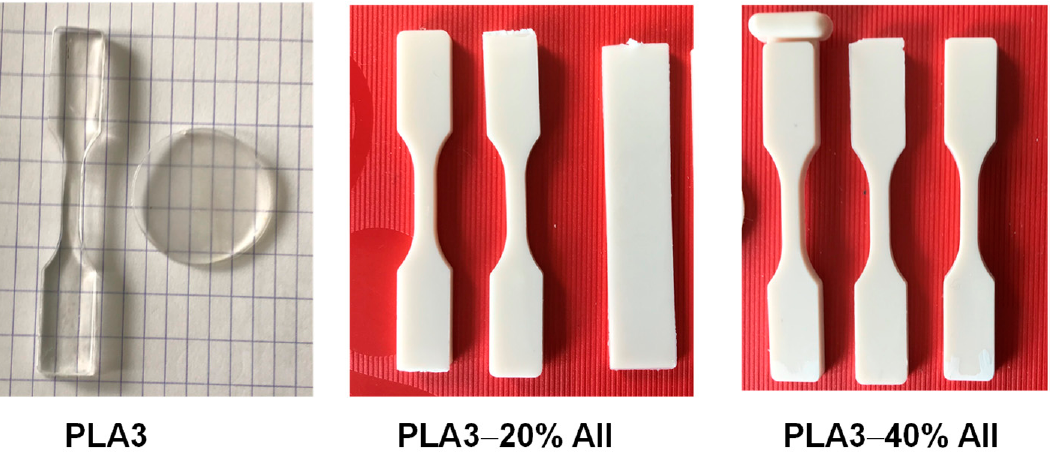
Figure 10. Selected pictures to illustrate the aspect of specimens of PLA and PLA − AII composites produced by IM.